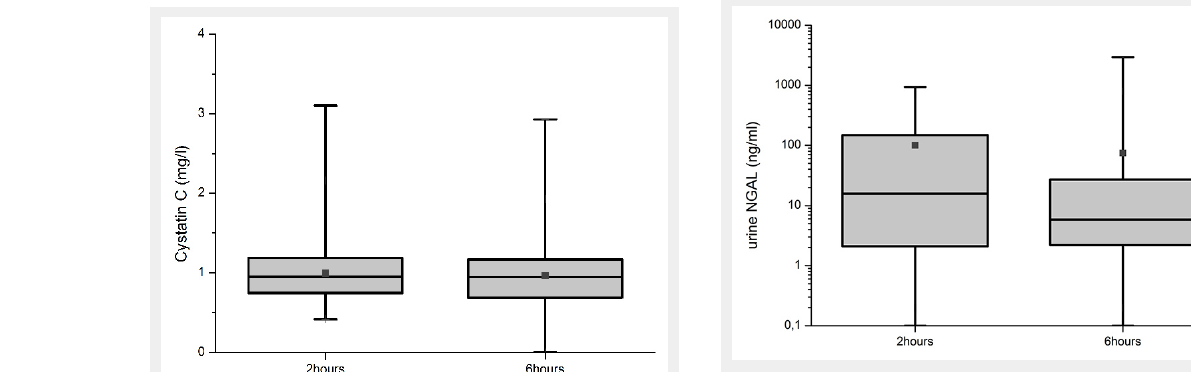
Box and whisker plot of serum Cystatin C concentrations 2 hours and 6 hours after the end of cardiopulmonary bypass. Boxes: 25 th percentile (bottom line), median (middle line), and 75 th percentile (top line); bars: range; squares: means.